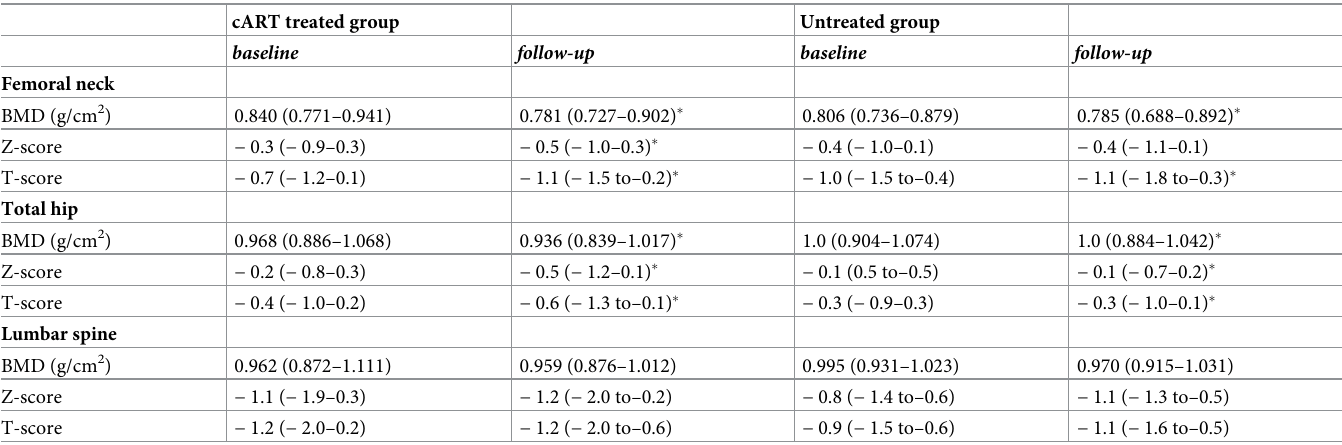
Table 2. Bone mineral density in PHI-men, median and